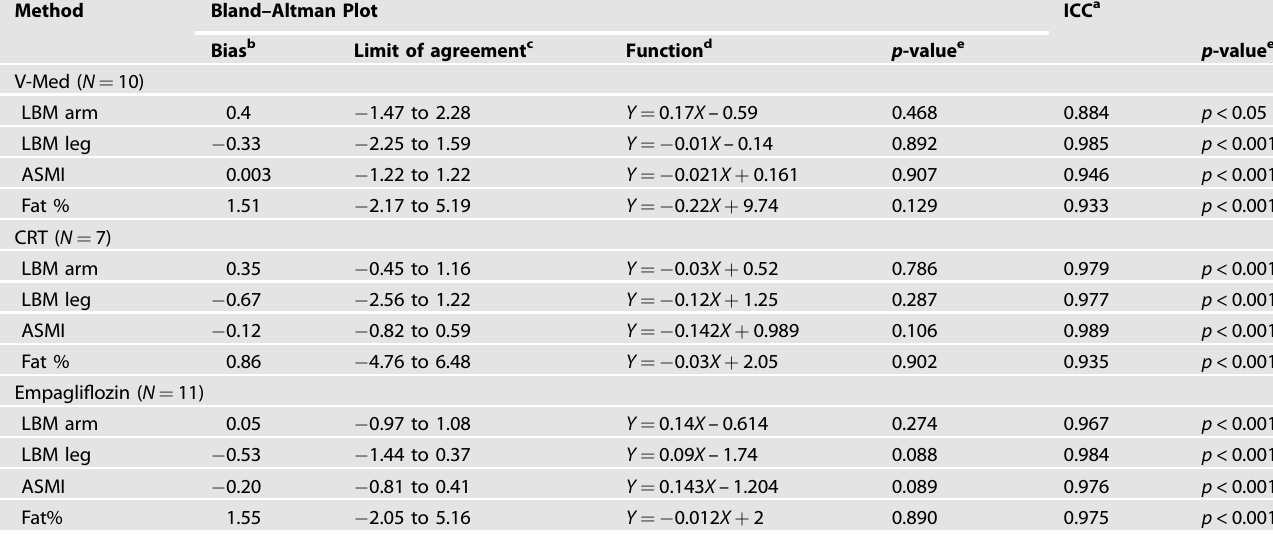
Table 3. Agreement of body composition measures assessed by DSMF-BIA and DXA among older adults with T2DM — after 10 weeks of V-MED, CRT, or empagli fl